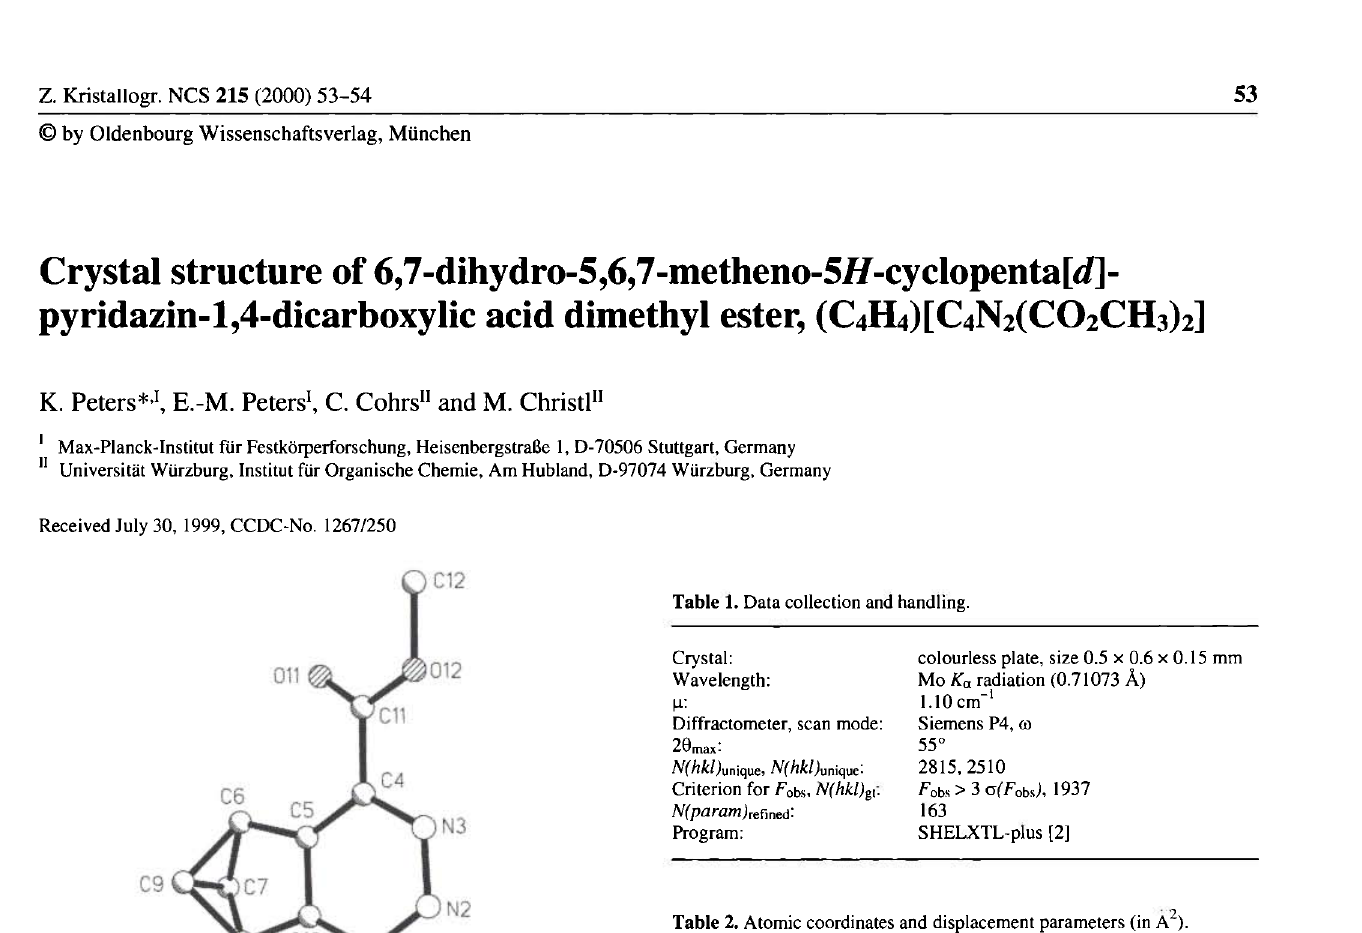
Table 2. Atomic coordinates and displacement parameters (in A 2 ).